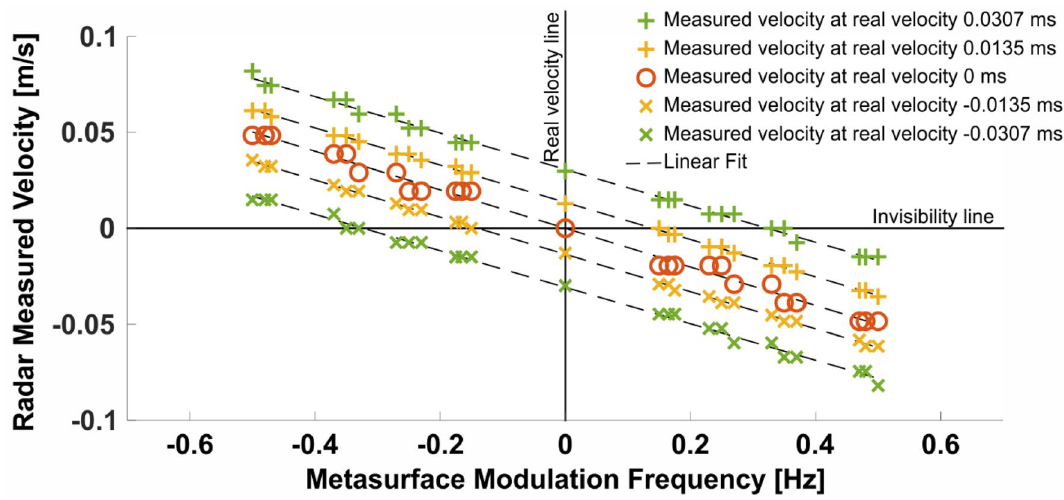
Figure 7. Measuring velocities from the phase plots by using the FFT method as in Eq.